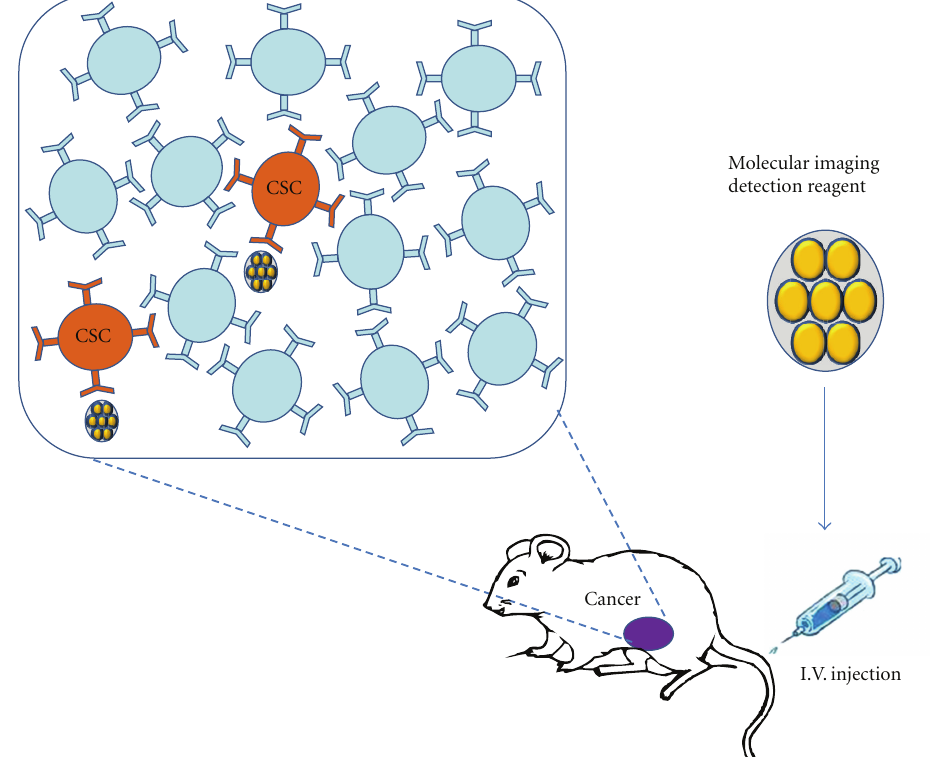
Figure 4: Paradigm of the application of molecular imaging in CSCs detection based on cancer stem cell model. Red and blue indicate cancer stem cells (CSCs) and non-CSCs,